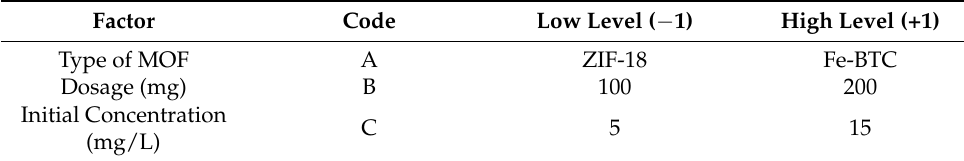
Table 1. The factors and their corresponding levels used in the factorial design.